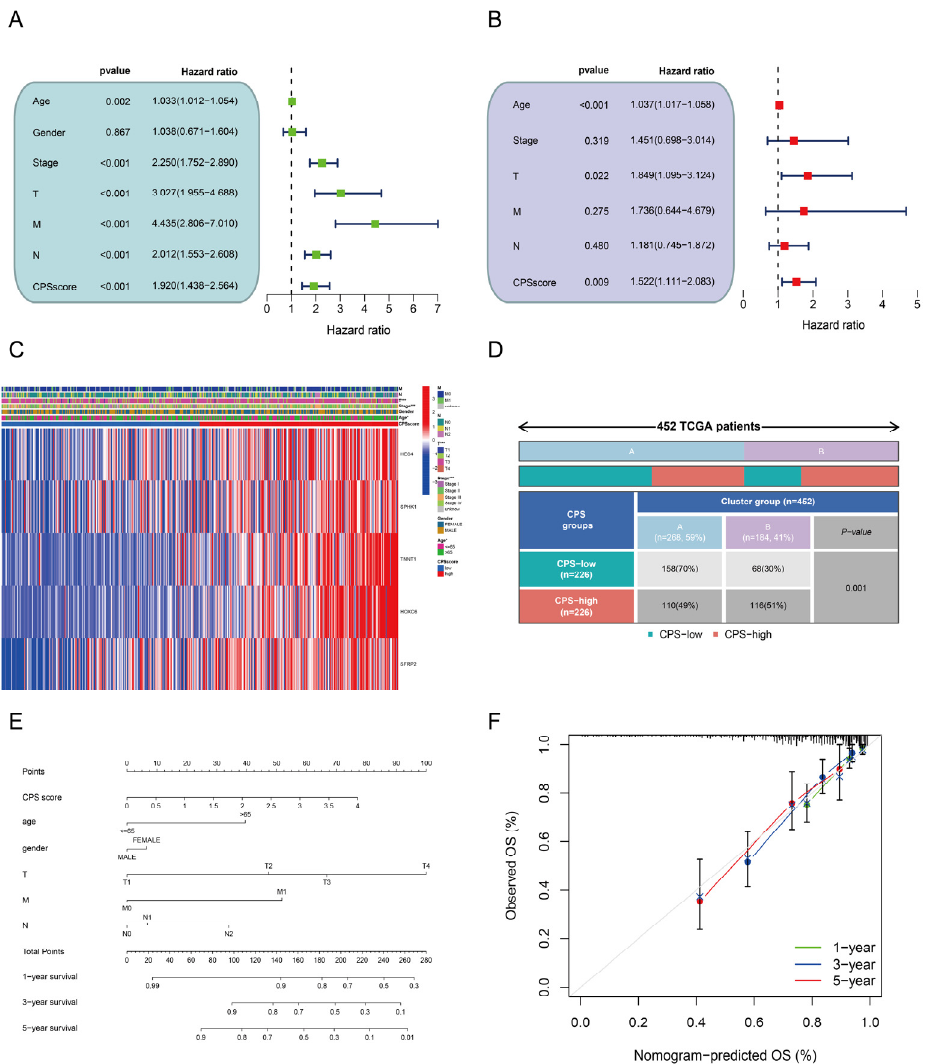
Figure 5. Clinical characteristics analysis of the CPS score. ( A ) Univariate and ( B ) multivariate Cox analysis based on CPS score and clinical covariates. ( C ) The heatmap shows the clinicopathological characteristics and the expression levels of five model genes. ( D ) Correlation between high and low CPS-score groups and cuproptosis subtypes. ( E ) A nomogram that predicts overall survival at 1-, 3-, and 5 years in patients with colorectal cancer. ( F ) Calibration curve of the nomogram. * p < 0.05; *** p <